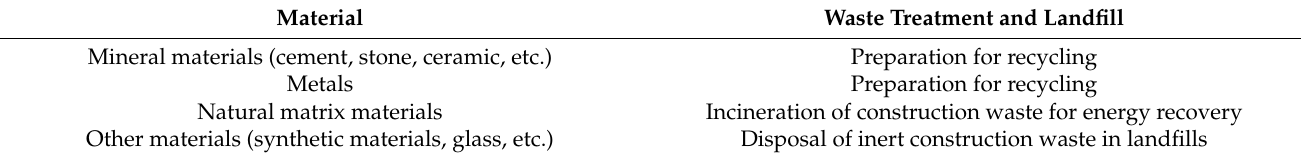
Table 3. Phase C1–C4: waste treatment processes considered in the